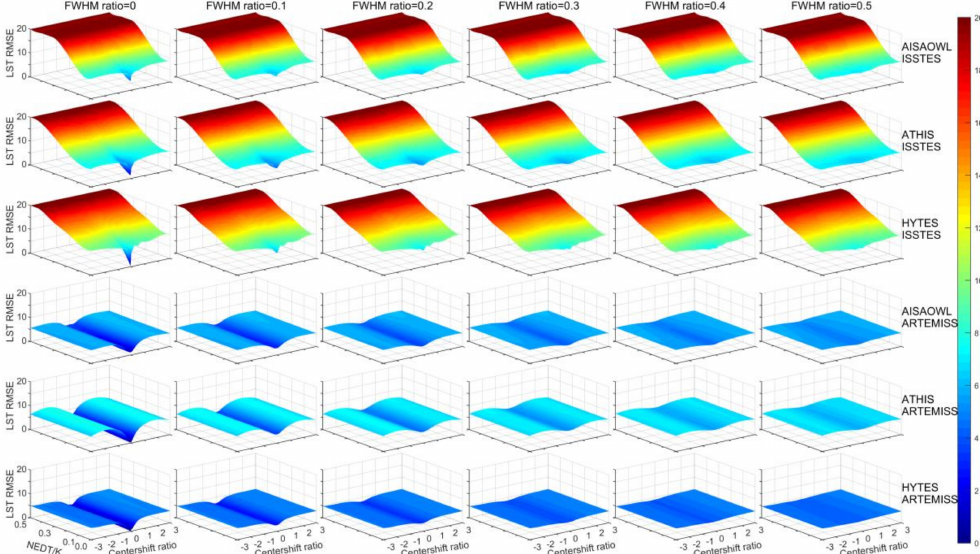
Figure 3. Distribution trend of the retrieval LST errors with the center wavelength shift ratios, FWHM change ratios and NEDTs. The sub-images have a same coordinate system with consistent axis ranges and color bar, where the X axis on the right hand side is the center wavelength shift ratio, the Y axis on the left hand side is instrument noise NEDT (K), the vertical Z axis is the LST RMSE (K), and the color is proportional to the error. Each sub-image has a constant the FWHM change ratio. 1–3 rows: LST errors of AISAOWL (100nm), ATHIS (50nm) and HYTES (35 nm) inversed by ISSTES respectively; 4–6 rows: LST errors of AISAOWL (100nm), ATHIS (50nm) and HYTES (35 nm) inversed by ARTEMISS